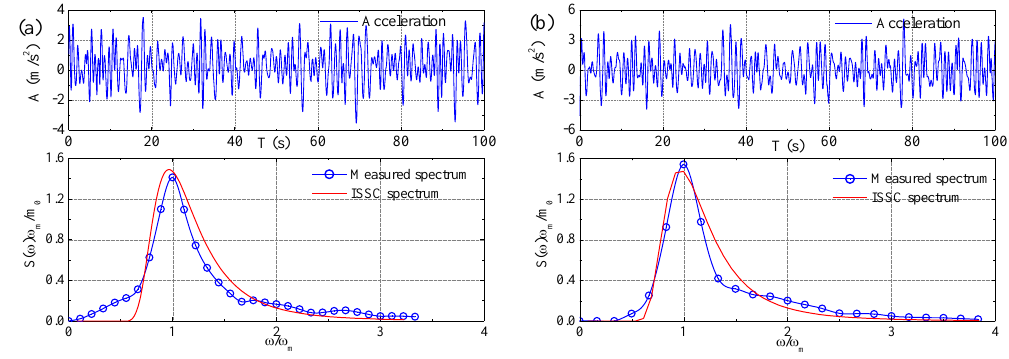
Figure 28. Wave data for large-scale model test: ( a ) the design sea state; and ( b ) the extreme sea state.